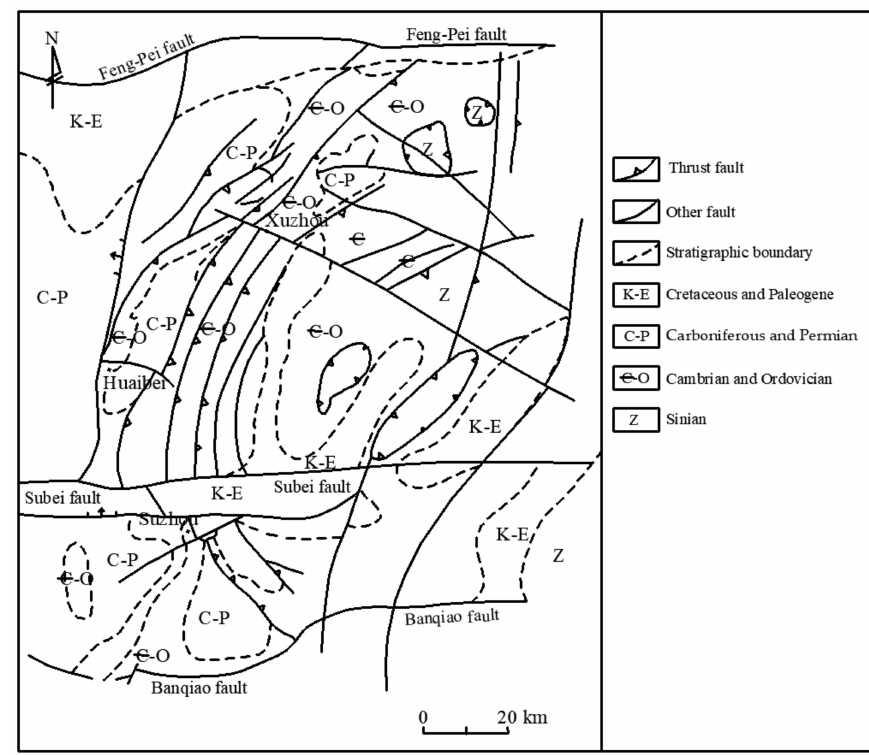
Figure 3. Geological map of the Xuzhou–Suzhou arc nappe tectonic. Modified from